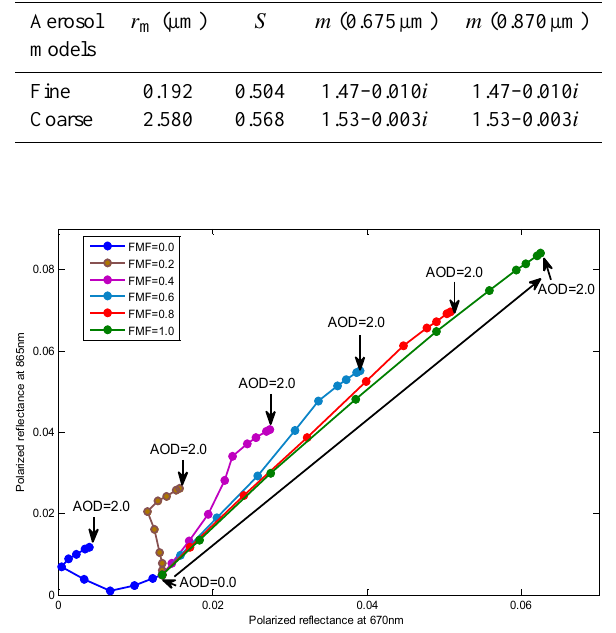
Table 2. Detailed parameters of fine model and coarse model.